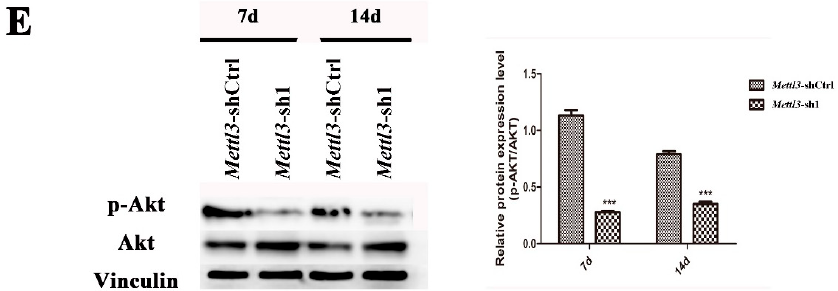
Figure 4. Differential expression of mRNAs between Mettl3 -knockdown and control. ( A ) The differentially expressed genes in Mettl3 -knockdown BMSCs under osteogenic induction medium are shown in the heat map. A p value cut-off of 0.05 and a Log2 ratio >2 or < − 2 were used as a filter to identify the differentially expressed genes. ( B ) The differentially expressed genes were counted; among these genes, 556 were upregulated and 641 were downregulated. ( C , D ) GO and KEGG pathway analyses of genes that were differentially expressed with a Log2 ratio < − 2, ordered according to gene enrichment. ( E ) The expression levels of total Akt and activated Akt (P-Akt) were assessed using Western blotting. Vinculin was used as an internal control. The band intensities were analyzed using ImageJ software. All of the results represent the mean ± standard deviation of three independent experiments ( n = 3). Significant difference compared with the control (*** p < 0.001).